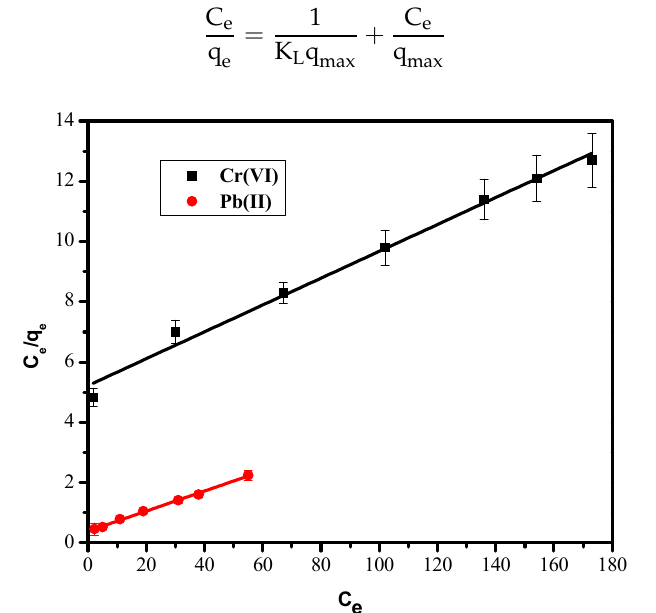
Figure 5. Linear fit of experimental data obtained using Langmuir isotherm model (adsorbent mass: 0.80 g/100 mL for Pb(II) at pH 4.6 and 1.00 g/100 mL for Cr(VI) at pH 4.0; temperature: 25 °C).